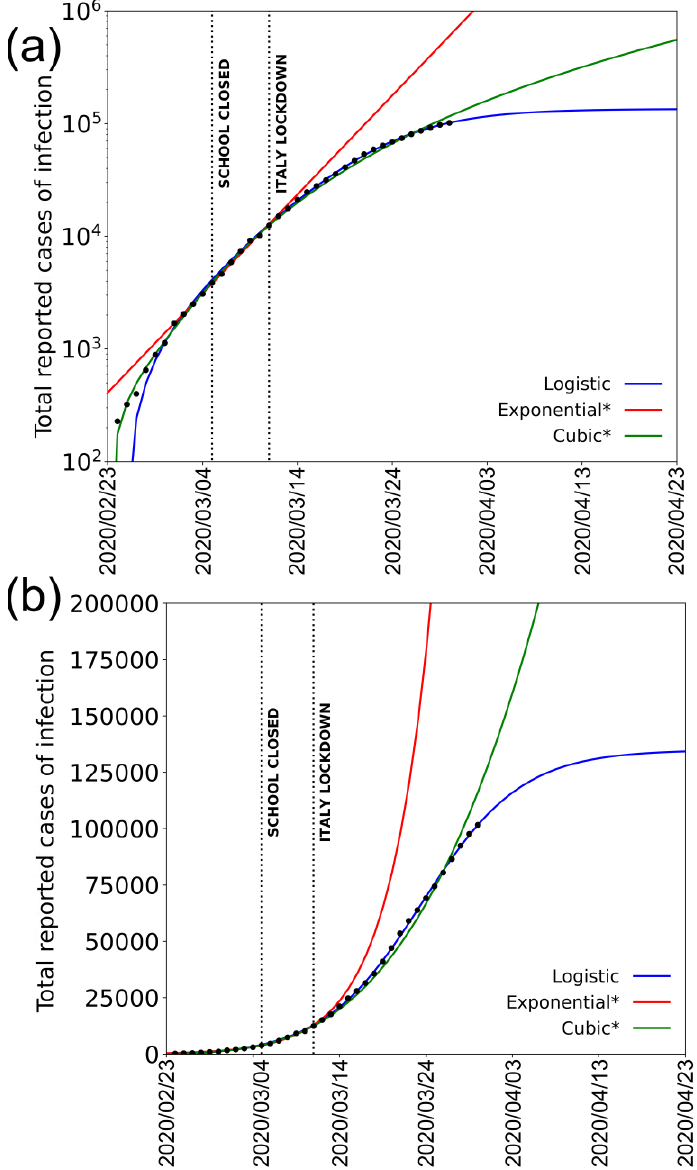
Figure 1. Total COVID-19 cases reported in Italy from 24 February to 30 March 2020 according to Protezione Civile (black dots) with logistic (blue solid line), exponential (red solid line), and cubic (green solid line) infection rates. Dotted black vertical lines mark the dates of Italian school lockdown and the nationwide total lockdown; the asterisk indicates that the exponential and the cubic fits are based on data until 12 March: score from Akaike Information Criterion (AIC) test (not reported) on logistic, cubic, and exponential fits shows higher reliability of the first two after this date and for the logistic against the cubic after 25 March 2020. ( a ) Fits obtained from the data in semi-logarithmic scale; ( b ) same data and fits shown in linear scale. Fit parameters: Logistic ( y = K 1 + me xr ; K = ( 135 ± 2 ) · 10 3 , m = − 1.4 ± 0.2, n = 170 ± 9, r = 0.174 ± 0.003 ) ; 1 + ne xr Exponential ( y = Ae Bx ; A = 410 ± 30, B = 0.2 ± 0.01; Cubic = a + bx + cx 2 + dx 3 ; a = − 40 ± 20, b = 36 ± 8, c = − 6.7 ± 0.9, d = 0.44 ±